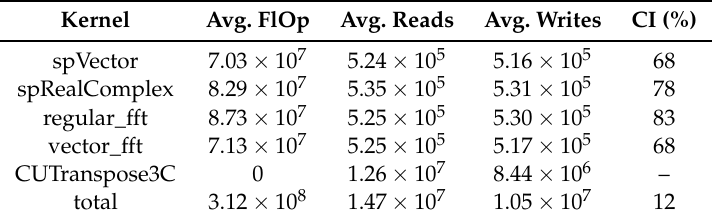
Table 4. NVProf output for configuration 2 in Table 3 for each invocation of each kernel. All kernels are from cuFFT, except the transpose kernel. Computational intensity is provided in the last column. The number of invocations of each kernel in one time step of the run is